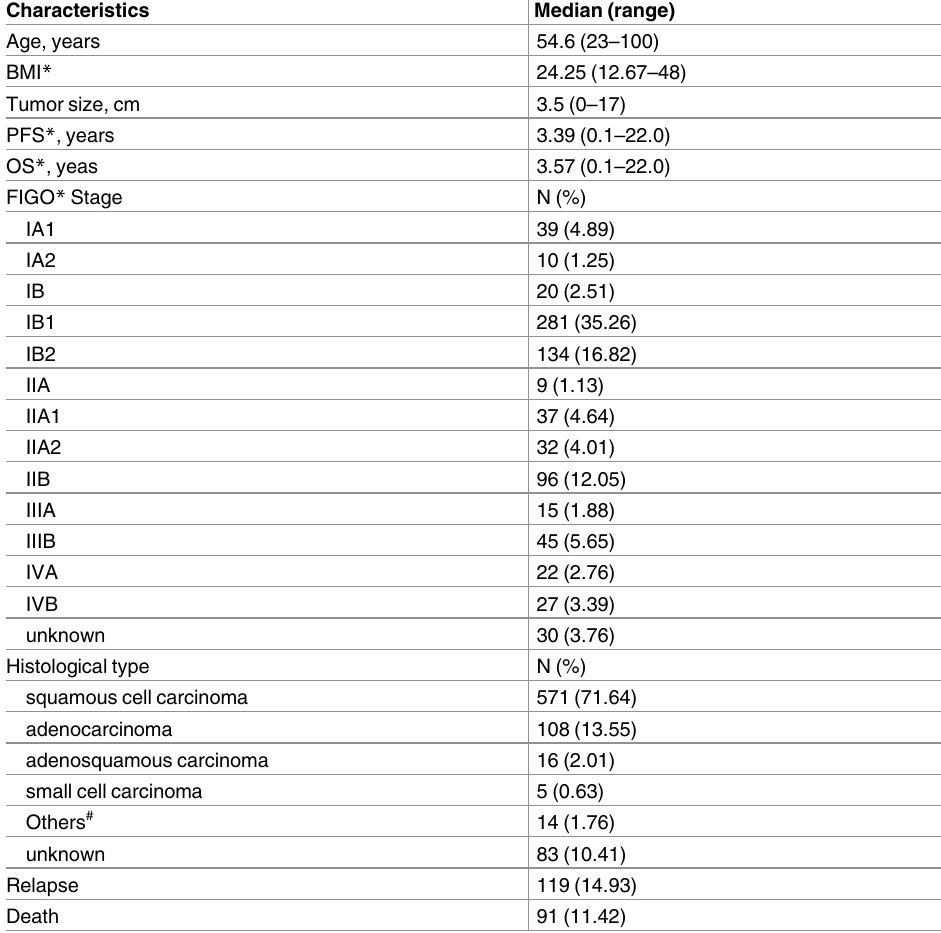
Table 1. Distribution of the patients’ baseline characteristics.